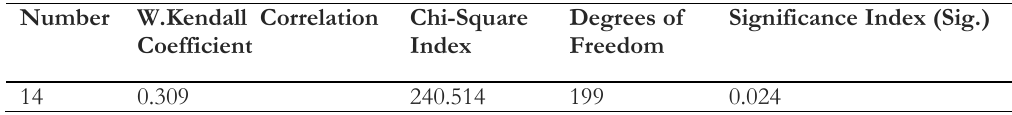
Table 1. Kendall W correlation test (first round Delphi).